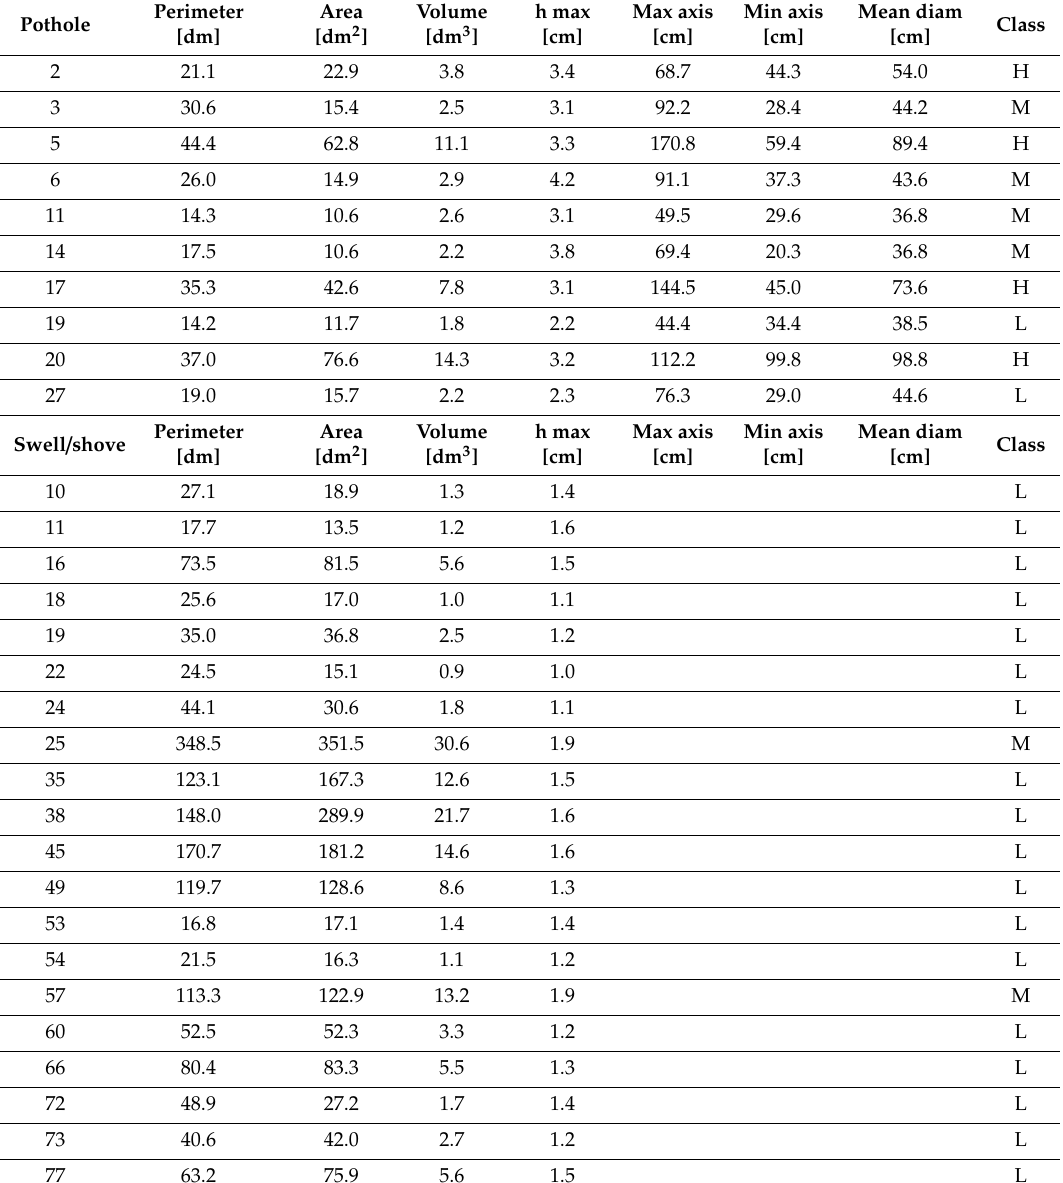
Table 3. The main geometrical parameters computed for some distress examples.